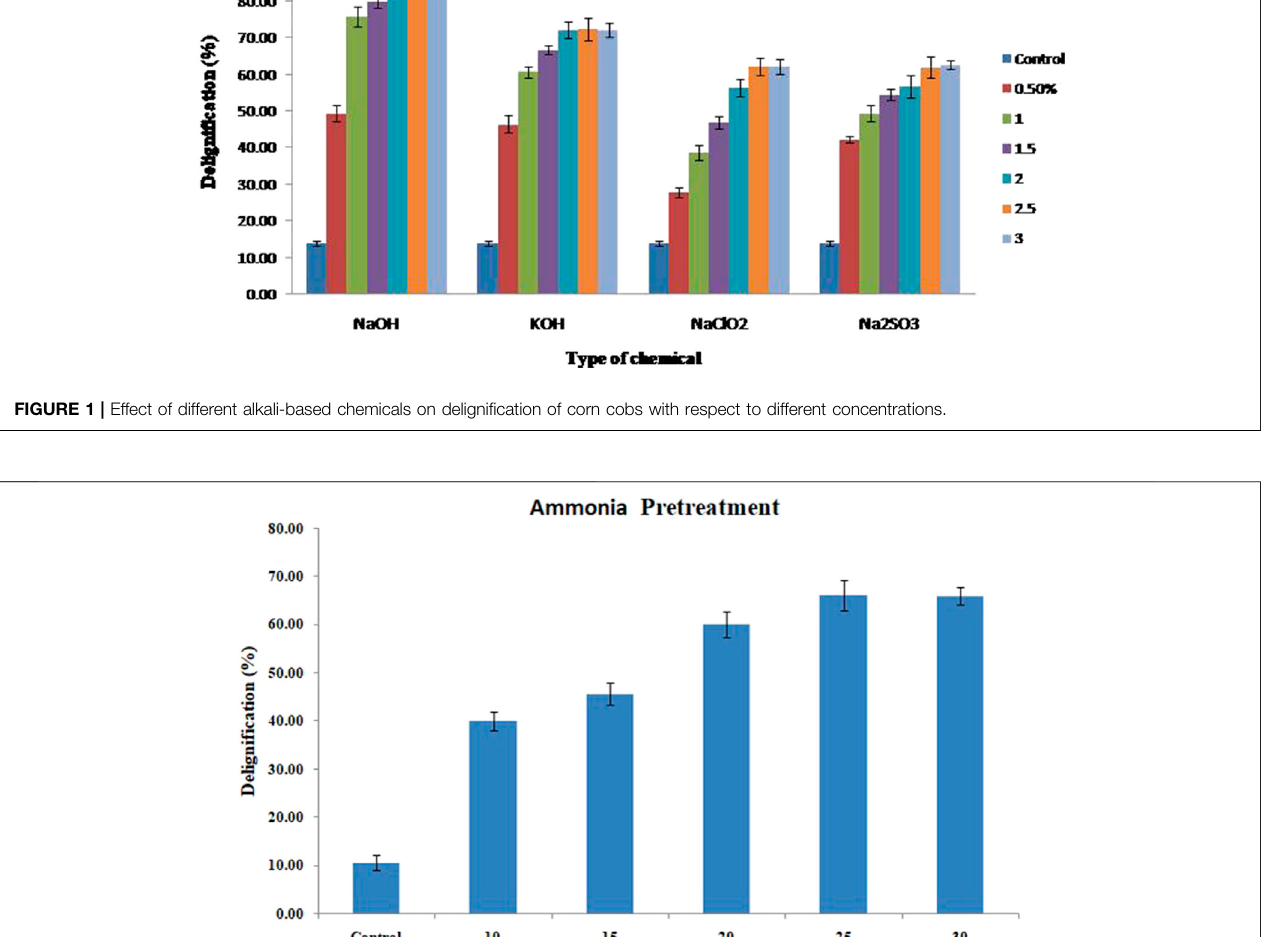
Frontiers in Energy Research |